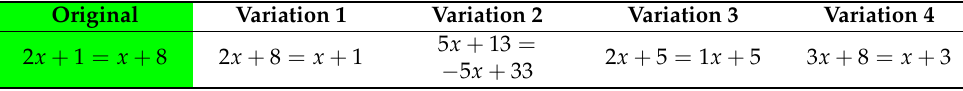
Table 12. Examples of type 11 equations and variations with a > c .